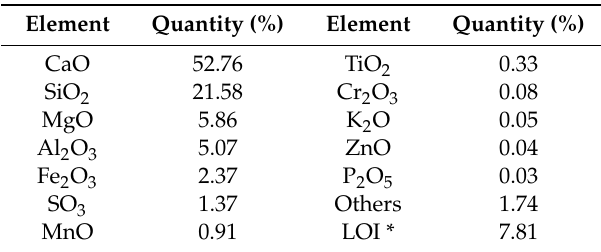
Table 1. Chemical composition of ladle slag (XRF).